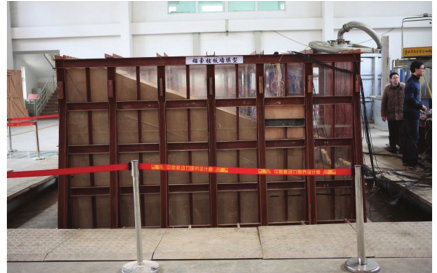
Figure 5: Shaking table test of antisliding